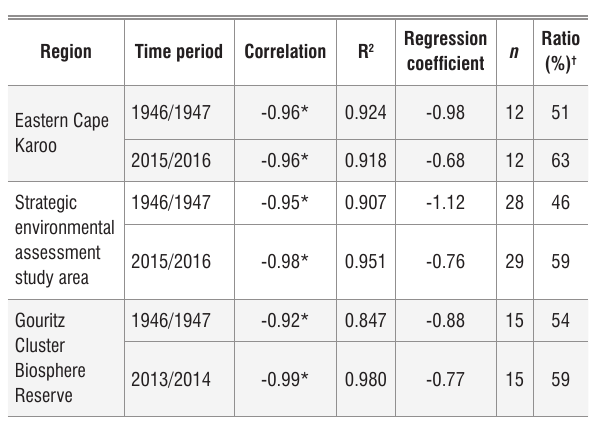
Figure 2: Example of a power law describing the rank-size relationship of enterprise numbers (in 2013/2014) of towns in the Gouritz Cluster Biosphere Reserve (GCBR), South Africa. The GCBR is used as an example. Enterprise number rank-size distributions of three South African regions for 1946 and 2011. Towns were ranked according to their enterprise numbers, and regressed as log log values of rank 10